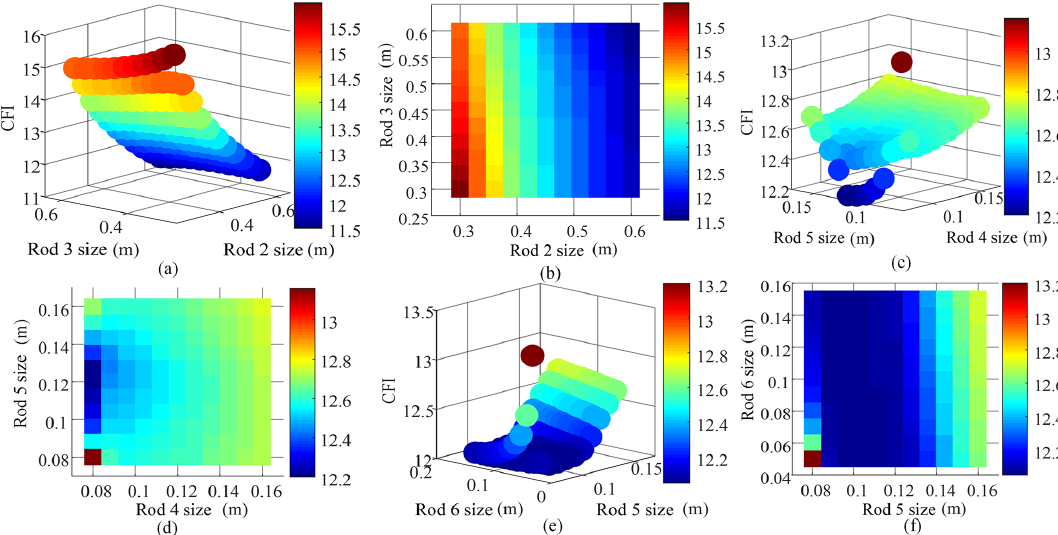
Figure 8. Effect of each link size on the comprehensive dexterity index. (a) The influence of rod 2 and rod 3. (b) The top view of the influence of rod 2 and rod 3. (c) The influence of rod 4 and rod 5. (d) The top view of the influence of rod 4 and rod 5. (e) The influence of rod 5 and rod 6. (f) The top view of the influence of rod 5 and rod